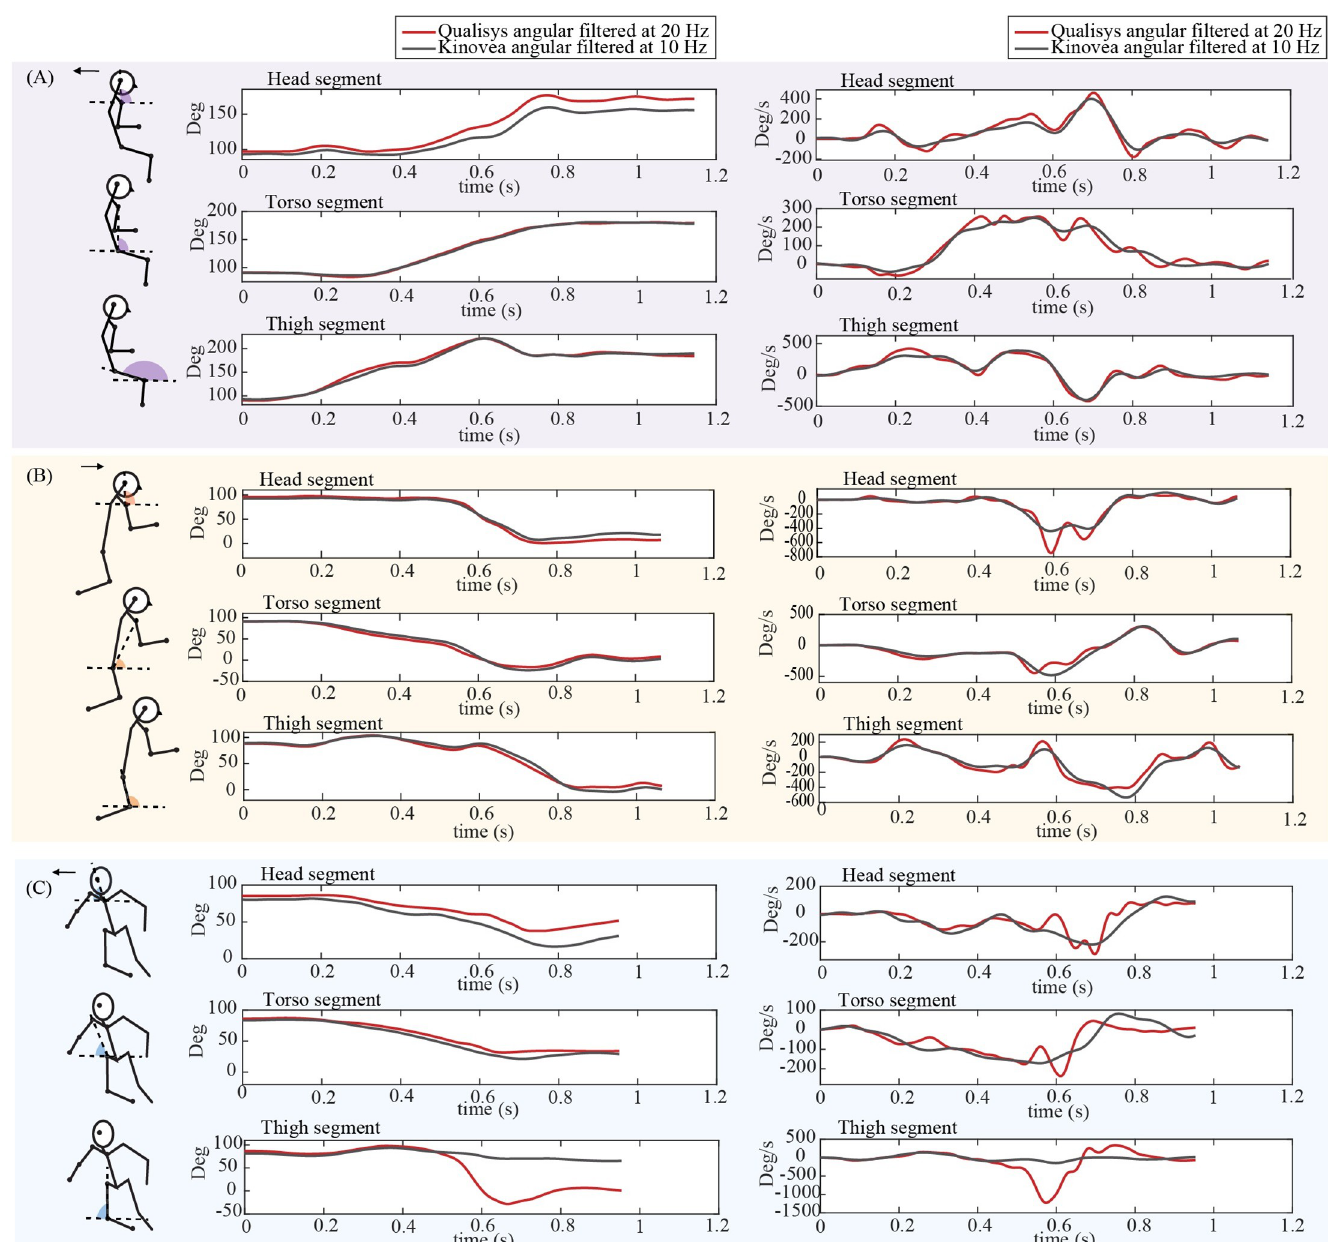
Fig 3. Angular positions and velocities measured from 3D motion capture (Qualisys) and Kinovea. The traces show time-varying angular positions (with respect to the horizontal) and velocities for selected body segments, measured for (A) backward, (B) forward, and (C) sideways perturbation-based falls. Data are for the same falls as shown in Fig